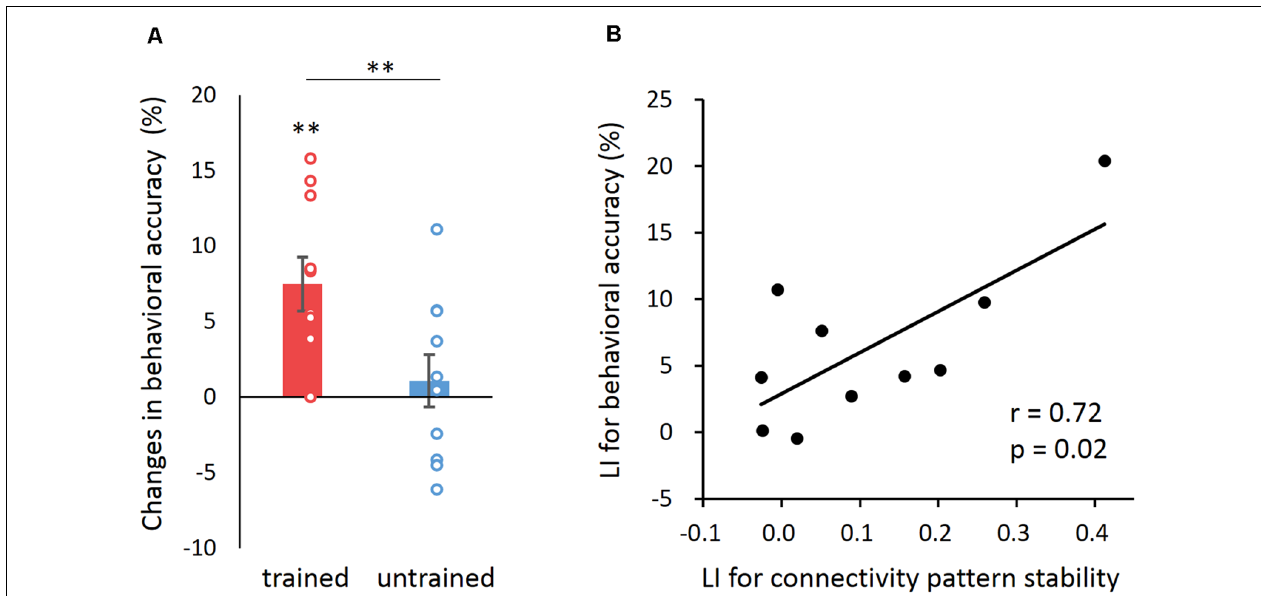
FIGURE 3 | The behavioral relevance of learning effect in connectivity pattern stability. (A) Changes in accuracy between the post- and pre-training behavioral tests for trained and untrained sequences. Error bars denote SEM. ∗∗ p < 0.01. (B) Correlation between the learning index (LI) of behavioral accuracy and that of connectivity pattern stability across participants. LI for both behavioral accuracy and FC pattern stability was calculated as follows: (trained_post − trained_pre) − (untrained_post −